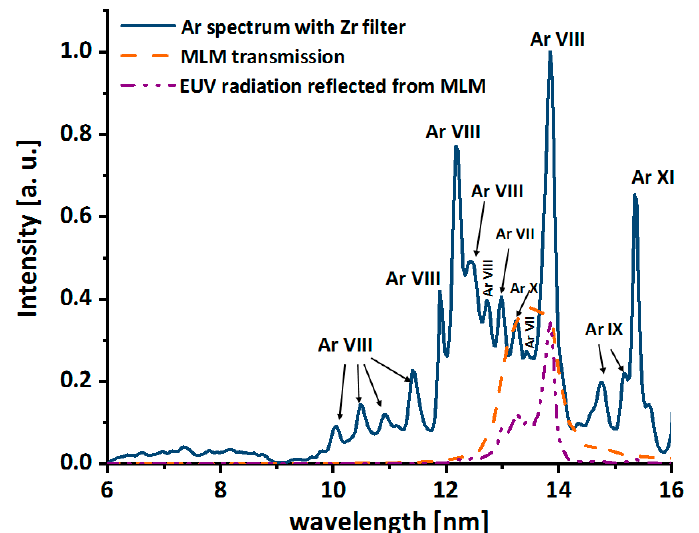
Figure 4. The spectrum of the Ar plasma emission (blue line) acquired with 20 EUV pulses and filtered using a 250 nm thick Zr filter. Radiation from the plasma was focused using the multilayer condenser mirror, which transmission is shown in orange, dashed line. The total contribution in the wavelength range 13–14 nm, used for imaging experiments, is shown as a purple, dash-dotted line. Figure modified, based on [58].